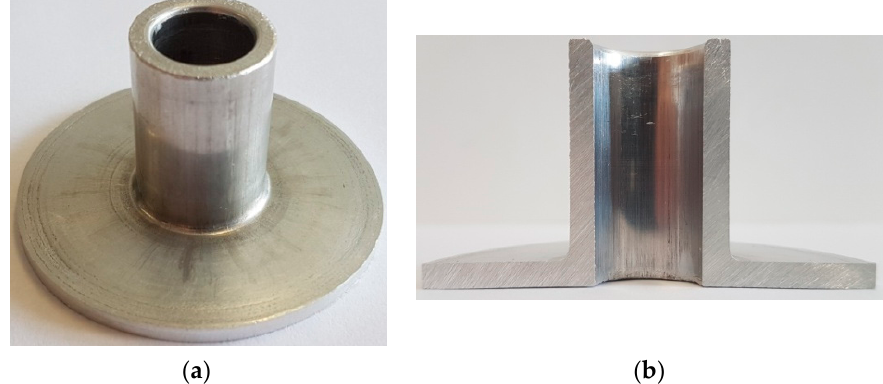
Figure 5. Hollow part with a 56 mm diameter flange: ( a ) perspective view, ( b ) axial section.